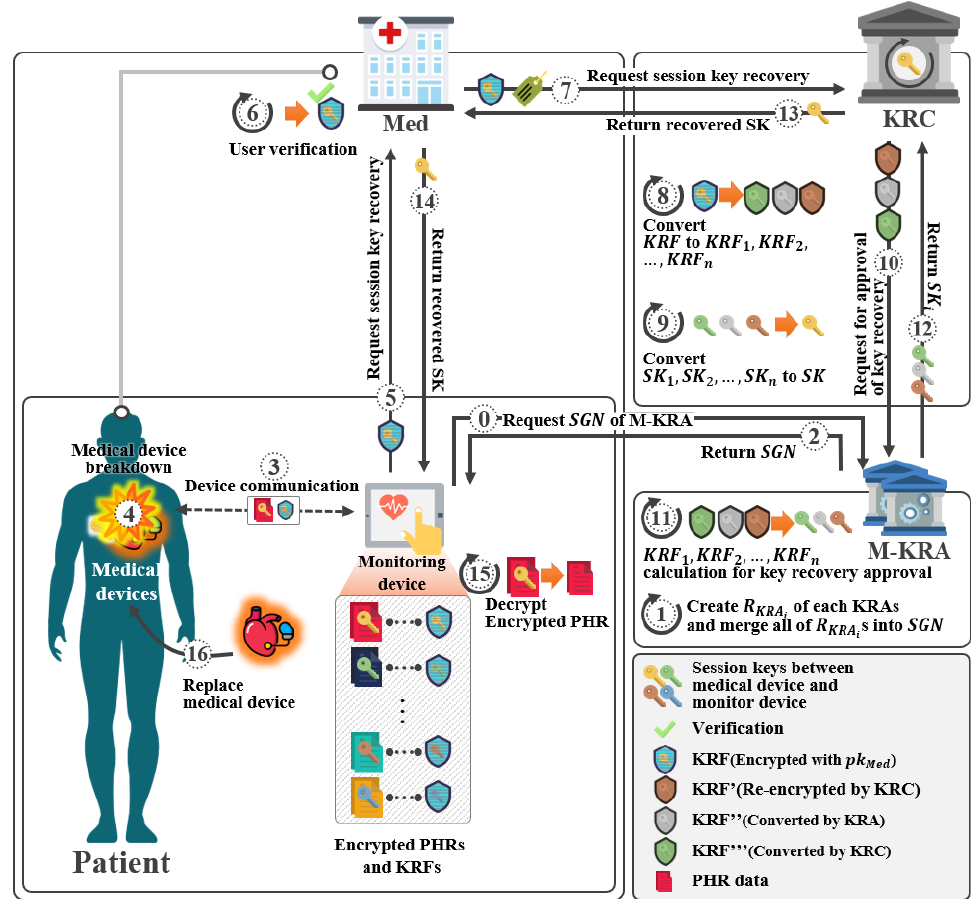
Figure 4. Scenario of proposed